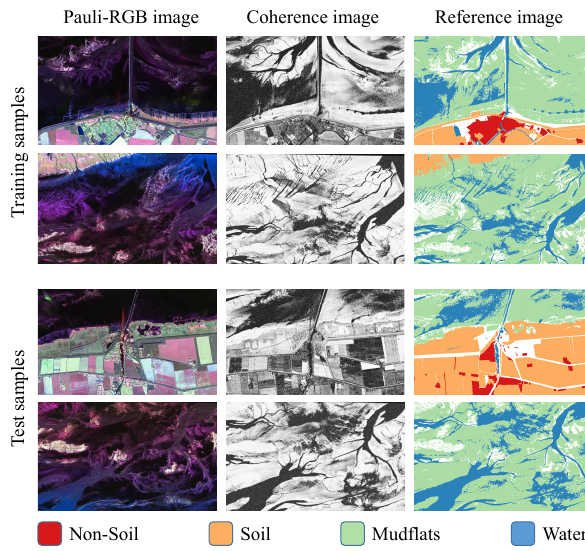
Figure 3. Exemplary image sections of training and testing data, including the Pauli-RGB image, the coherence image and the corresponding reference image containing class